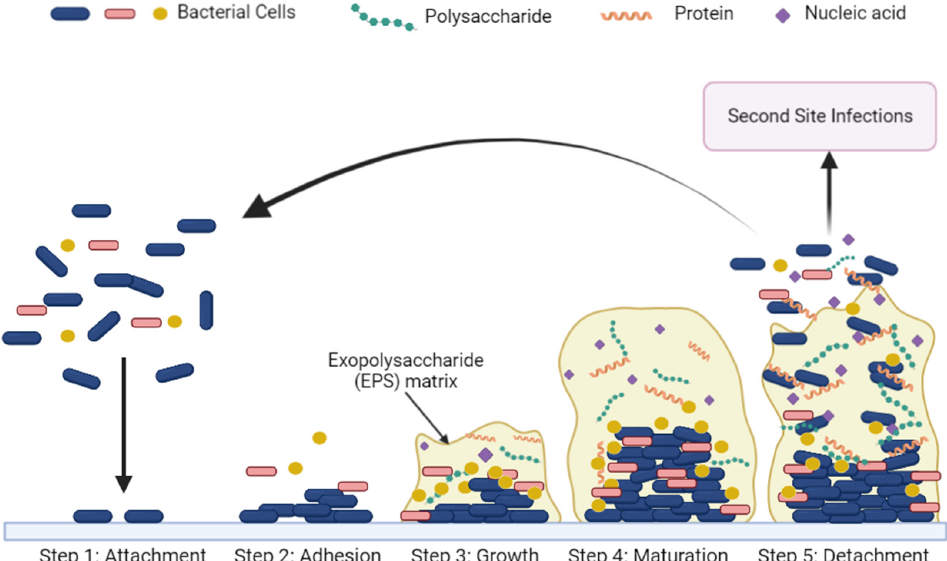
Figure 1. Progression of biofilm formation in the oral cavity. In the attachment stage (Step 1), planktonic cells begin to adhere to a surface. A monolayer of planktonic cells accumulates on the surface during the adhesion stage (Step 2). During the growth stage (Step 3), sessile cells begin to excrete an exopolysaccharide matrix containing proteins, polysaccharides (carbohydrates) and nucleic acids that surround the cells. The EPS matrix assumes a mushroom cloud shape in the maturation state (Step 4). Finally, planktonic cells are released from the EPS matrix during the detachment stage (Step 5), allowing for dispersal and colonization of new sites. (Created with BioRender, accessed on 1 August 2022).